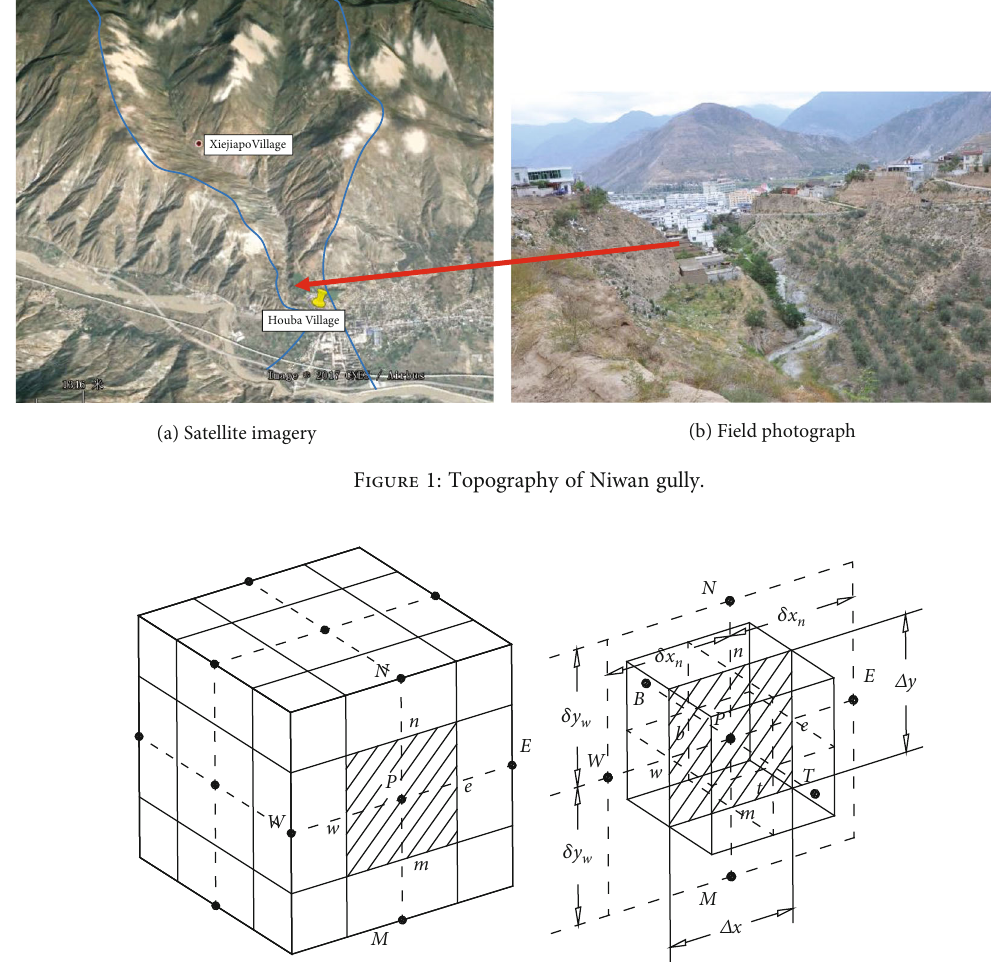
Figure 2: Schematic diagram of volume unit division in computational